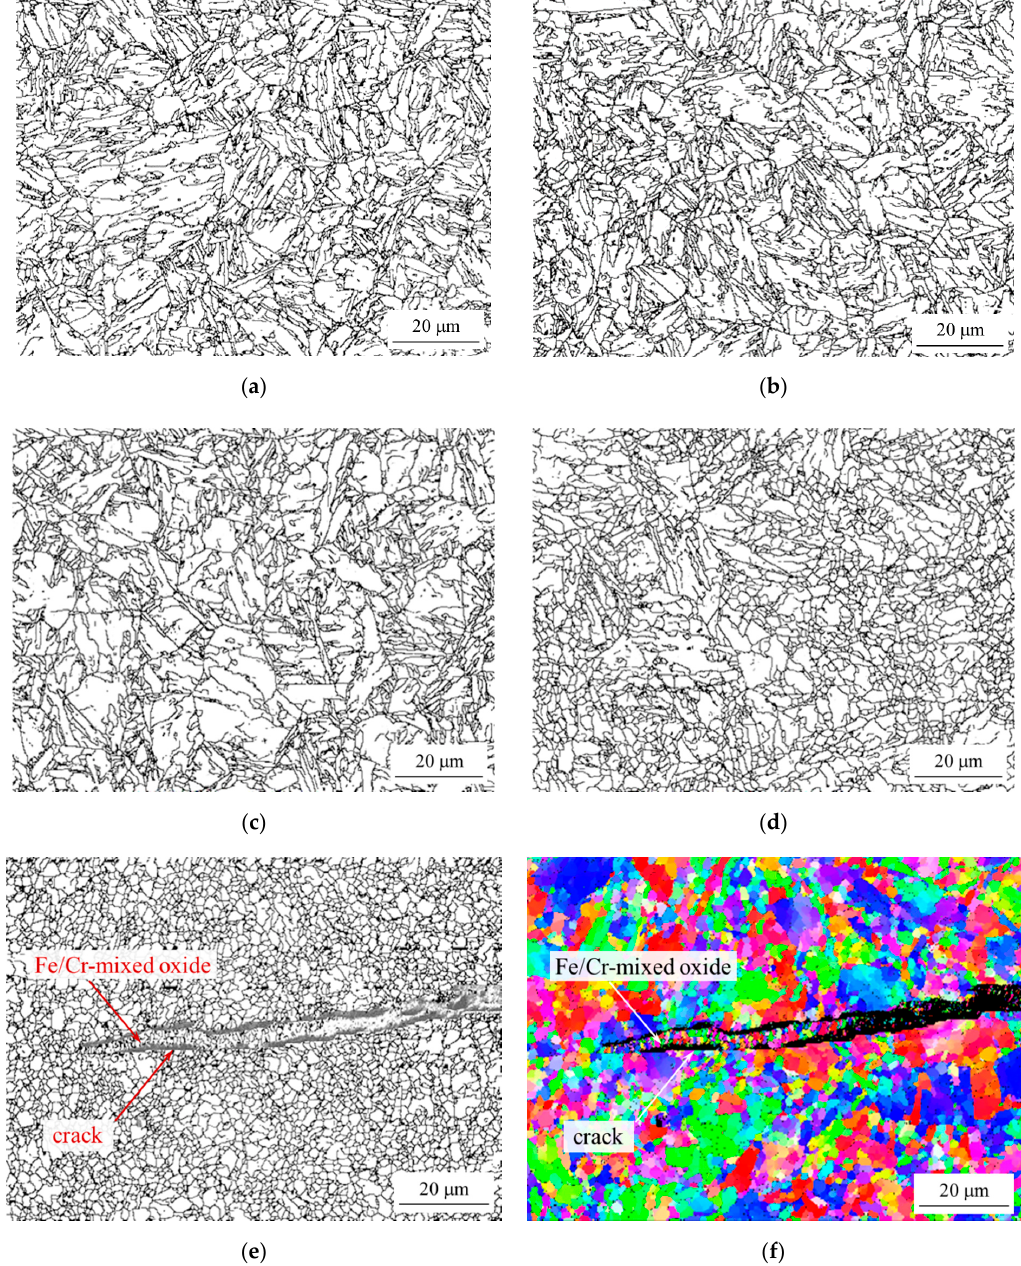
Figure 4. Binarized images ( a–e ) from post-processed electron backscatter diffraction band contrast images (misorientation angle used to define fatigue induced sub-grain boundaries: >3°, step size: 0.2191 μ m) for the quantitative analysis of martensite lath degradation and complete polygonization of ferritic-martensitic grade 91 steel after 0 ( a ), 10 ( b ), 250 ( c ), 1250 ( d ) and 3500 ( e ) TMF cycles. ( f ): Sub-grain orientation added to ( e ).